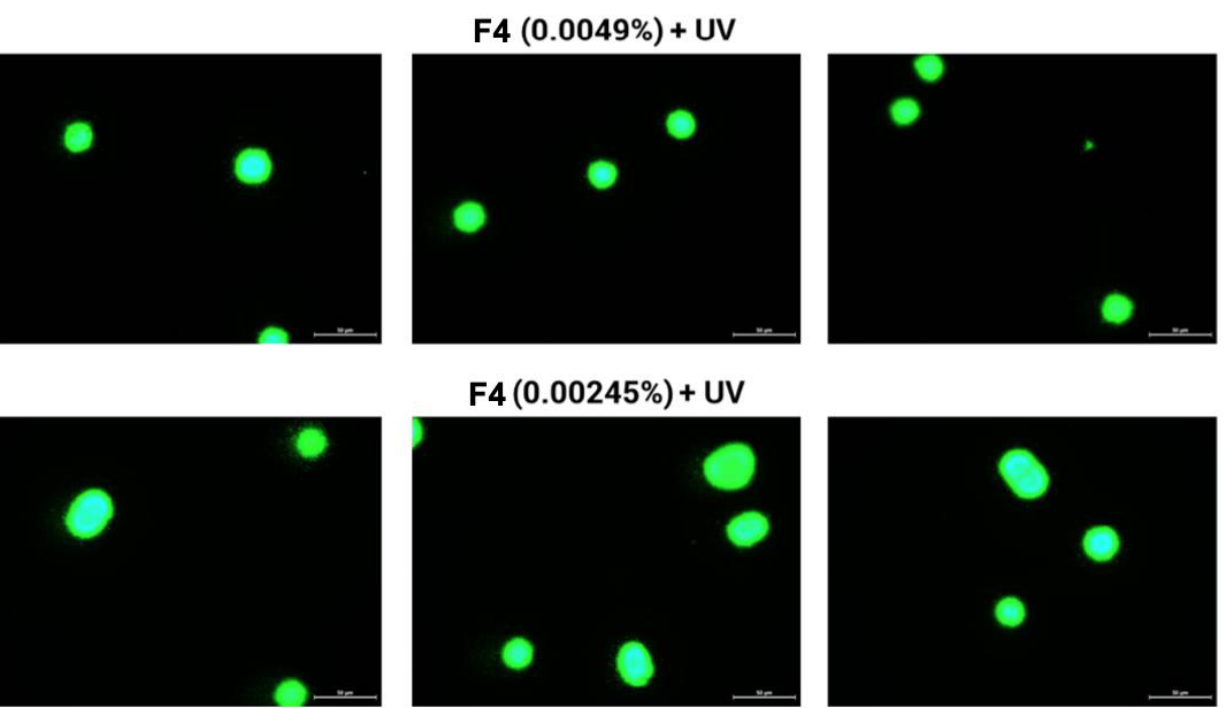
Figure 4. The comet assay method, microscope images at 1000 × magnification. Cell DNA damage in human keratinocytes, being basal control (cell culture in regular condition); UV control (cell culture submitted to UV radiation); and the test products F1, F2, F3, and F4 in cell cultures exposed to UV radiation. Table 2. In vivo skin biocompatibility by the corneometer, Tewameter TM 300, pH meter, and